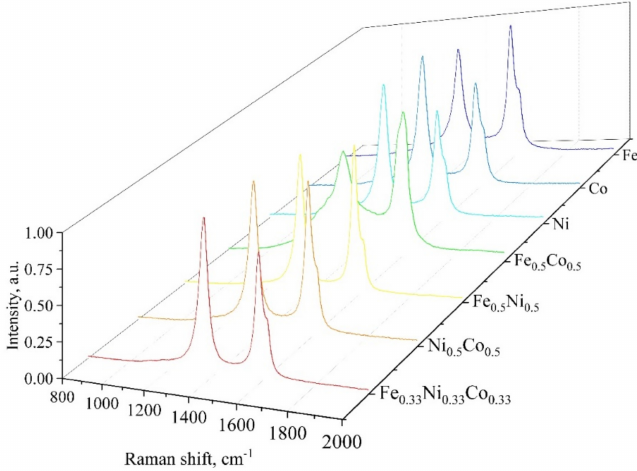
Figure 9. Raman spectra of the carbon nanotubes produced over di ff erent metallocene-derived catalysts.